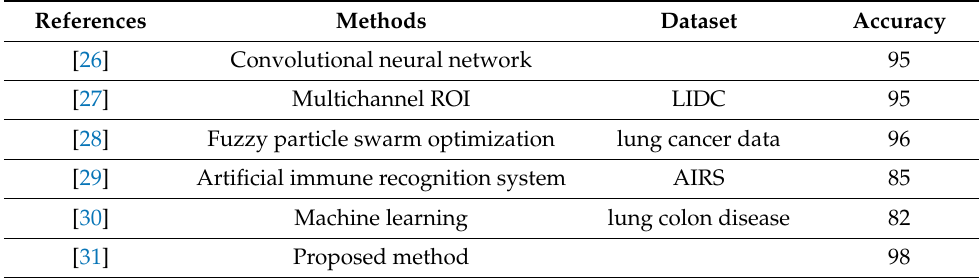
Table 1. Comparison